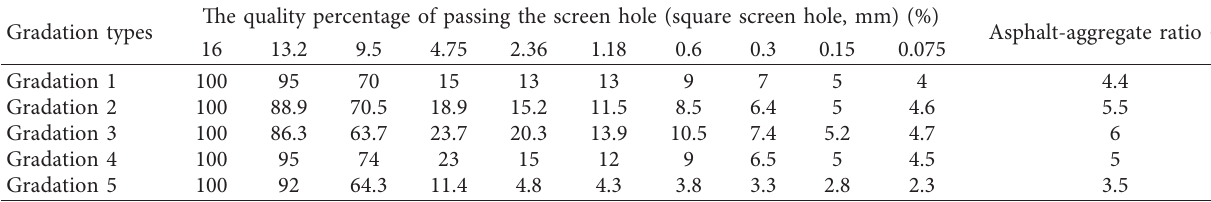
Table 9: Verification gradation.